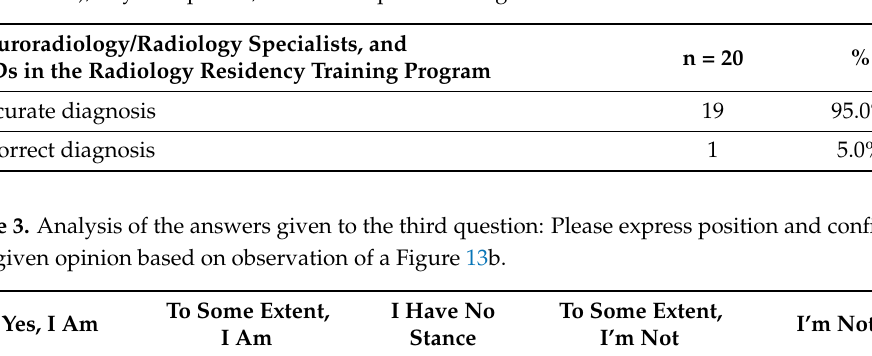
Table 2. Analysis of the given answers to the second question: Analyzing Figure 13b (SVMI of the non-contrast MDCT image of the endocranium of the same patient and the same region and cross-section), in your opinion, what is the possible diagnosis?